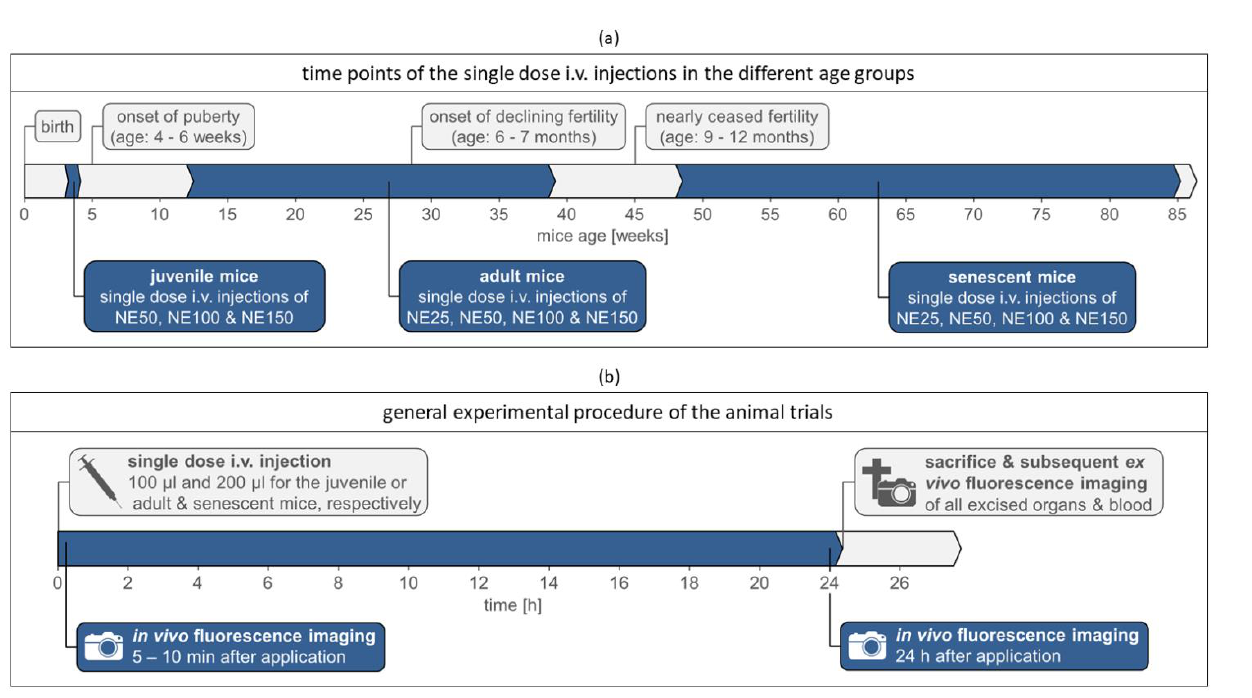
Figure 9. Experimental design of the animal trials: ( a ) time points of the single-dose i.v. injections with the nanoemulsions in the age groups juvenile, adult, and senescent, including the onset of puberty [24 – 26], the onset of declining fertility, and nearly ceased fertility of female mice [21,23,28 – 33]; ( b ) general experimental procedure of the animal trials.